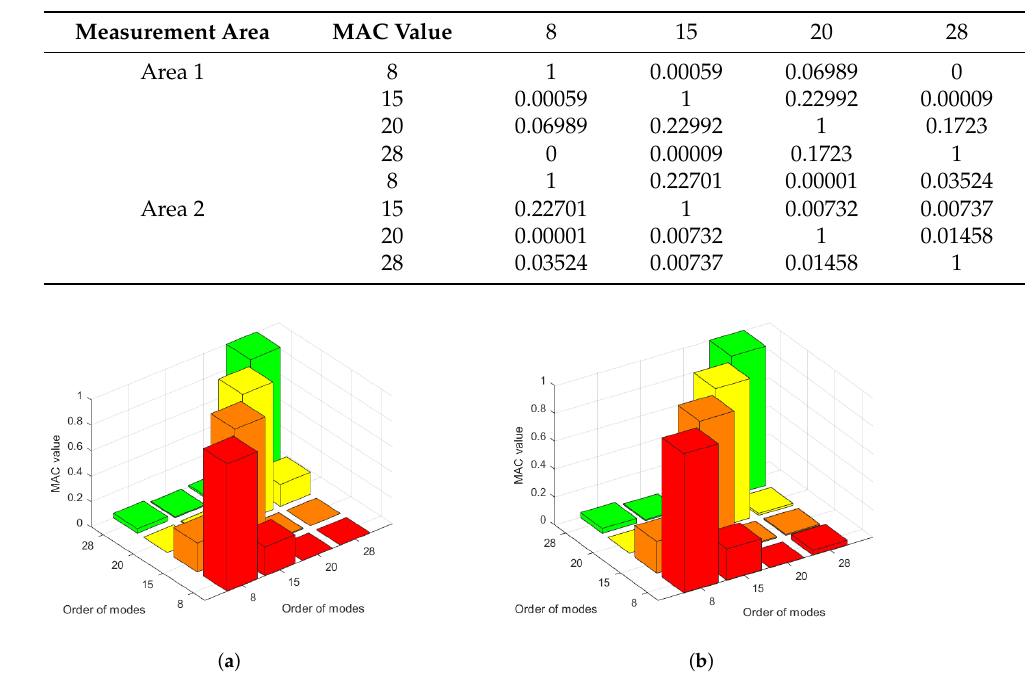
Table 4. Finite-element calculation of the MAC data of the first 4 main modes in the vertical direction.